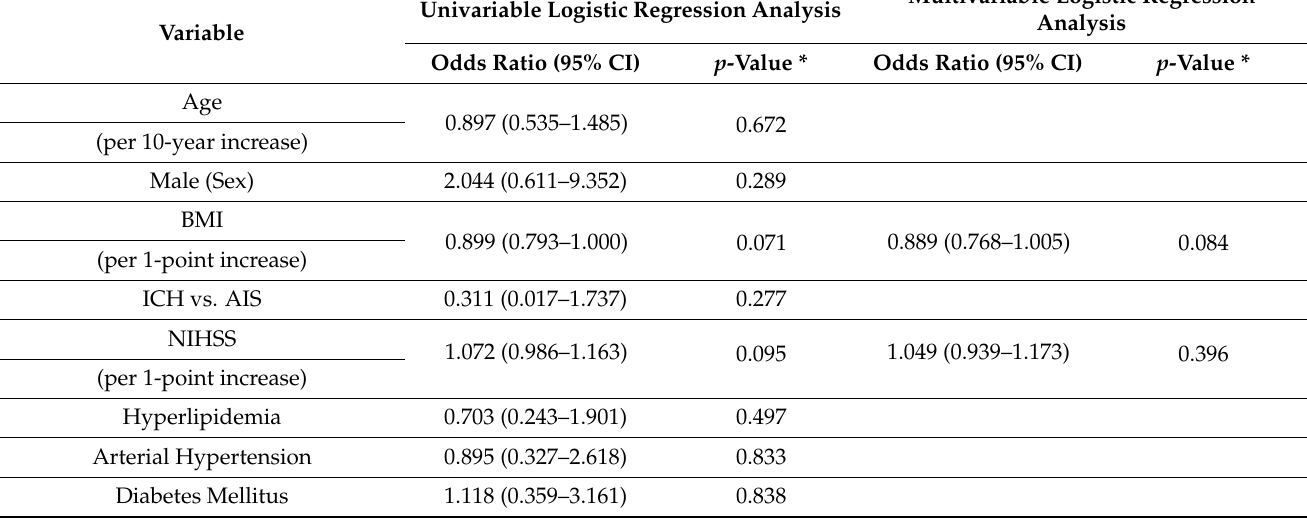
Table 4. Univariable and multivariable logistic regression analyses depicting the associations of baseline characteristics with the likelihood of detection of central apnea vs. obstructive apnea among patients with sleep-disordered breathing